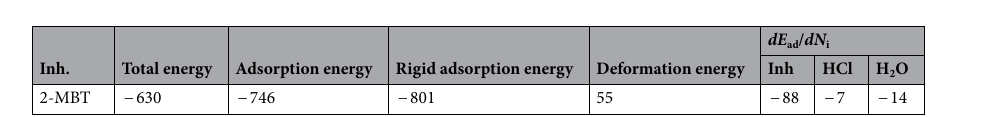
Table 9. Adsorption descriptors for Al(111)/2-MBT/(5 HCl/139 H 2 O) systems. All values are in kcal/mol.